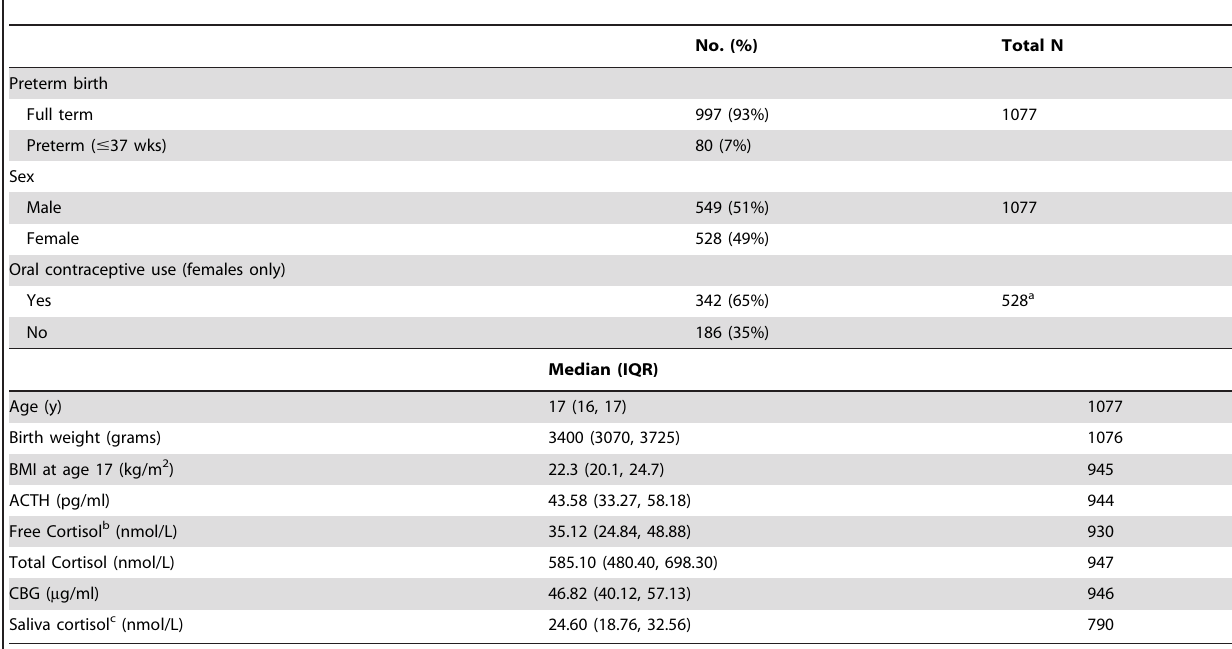
Table 2. Description of Raine Study population and summary of HPA